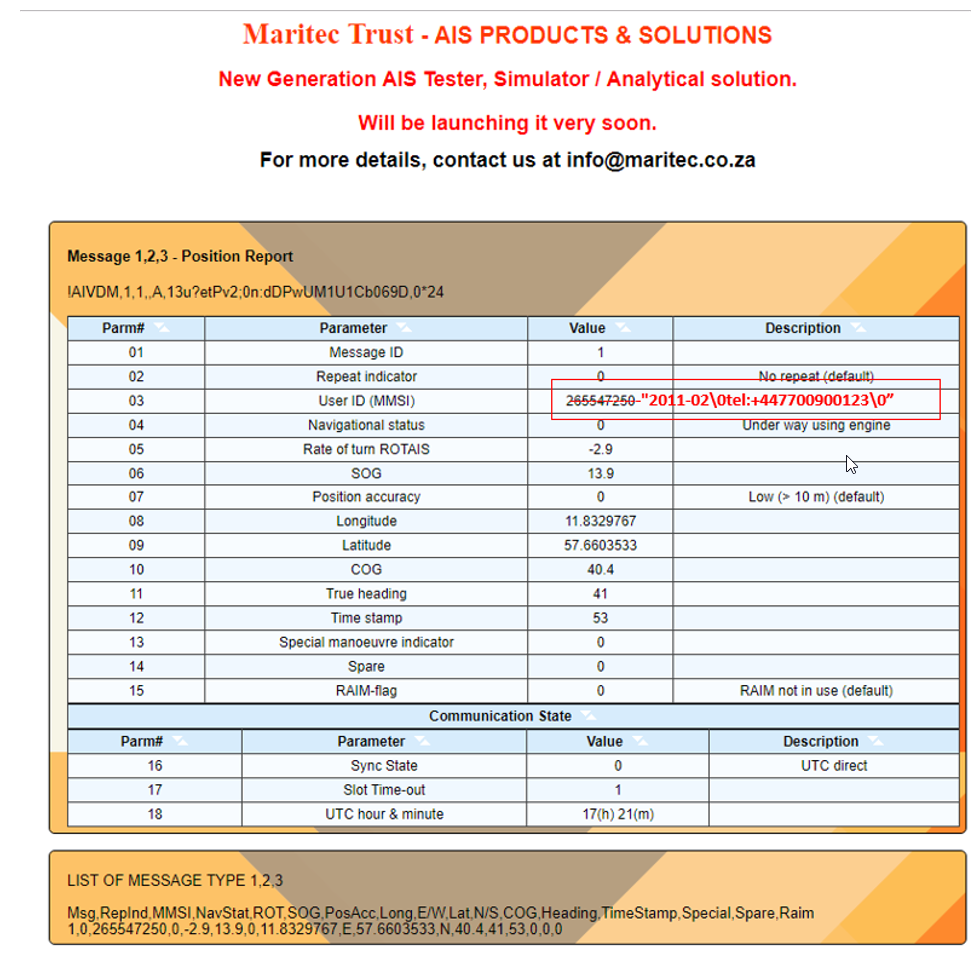
Figure 3. Original conventional ID1 AIS message.